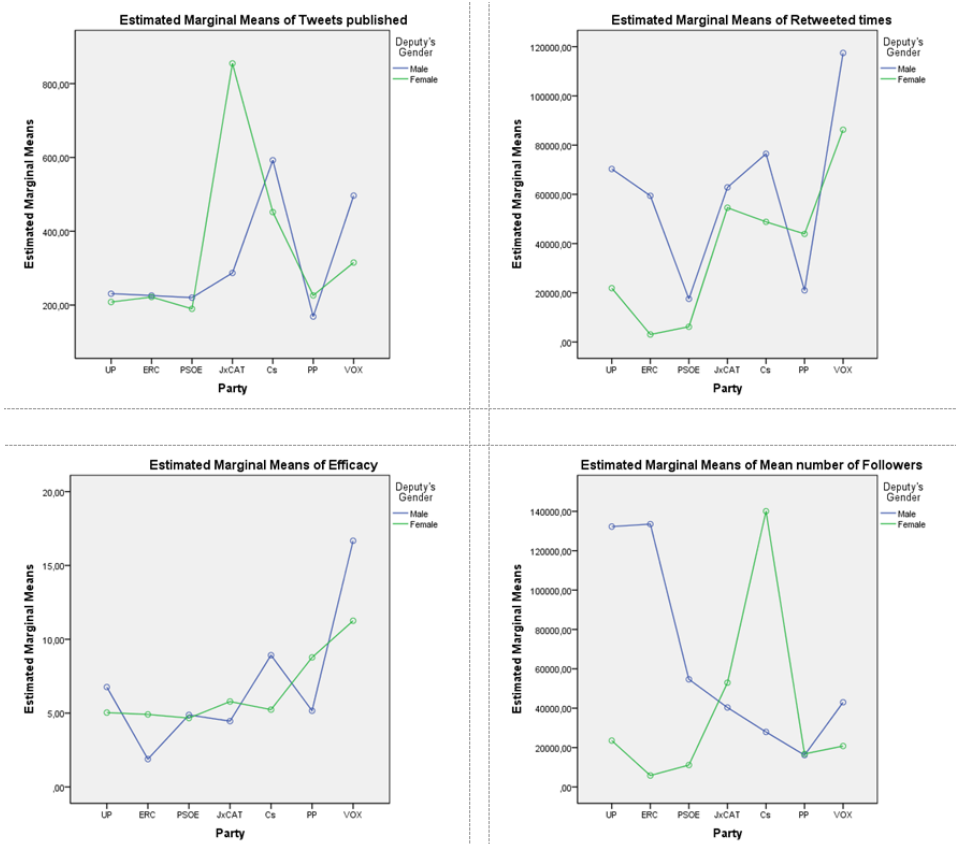
Figure 1. Mean amount, amplification, efficacy and audience of Spanish Members by gender and